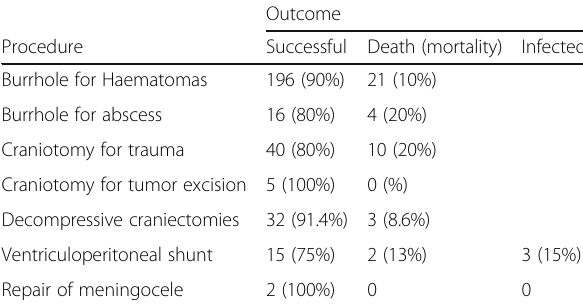
Table 3 Outcome of the intervention